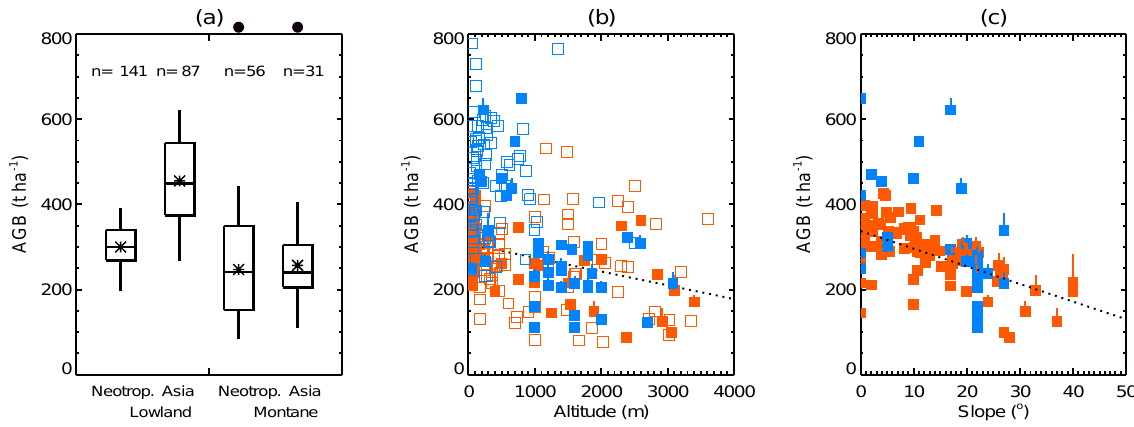
Figure 2. Above-ground biomass (AGB) storage estimated from forest inventory plots. (a) Comparison of AGB (on a land surface area basis) in tropical montane forests (elevation ≥ 1000m) with that in lowland tropical forests (star: mean, line: median, box: 25th and 75th percentile, whisker: 5th and 9th percentile). Significant differences between lowland and montane (Student’s t test, P < 0 . 01) indicated by a solid circle above panel. (b) Relationship between AGB and elevation (neotropics: red, Asia: blue). Open symbols show sites where no information on slope is available. (c) Relationship between angle of slope and AGB. In (b) and (c) , symbols show AGB per land surface area (linear relationship for the neotropics is shown with a dotted line), tops of bars show AGB per planimetric area.